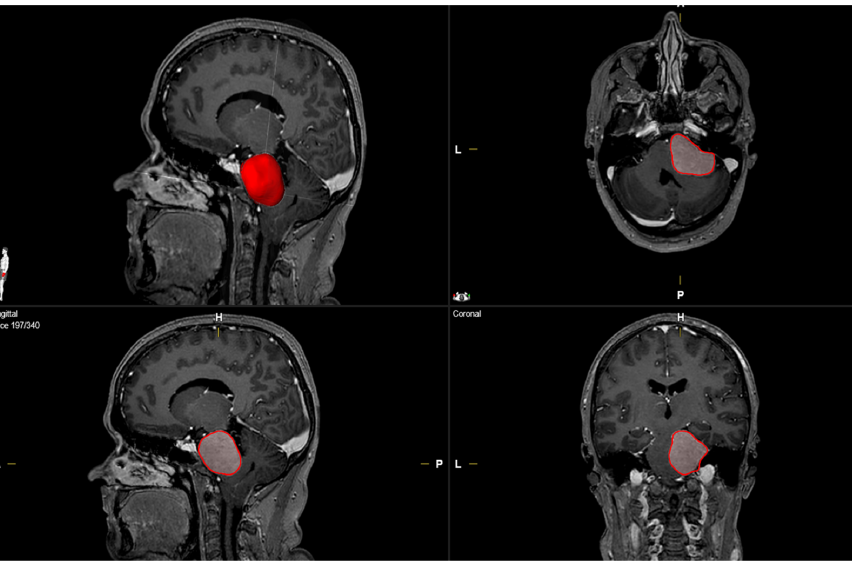
Figure 2. Illustrative determination of the tumor volume (red) in a female patient with a right-sided petroclival meningioma using SmartBrush (Brainlab Elements, Brainlab AG, Feldkirchen, Bavaria, Germany).